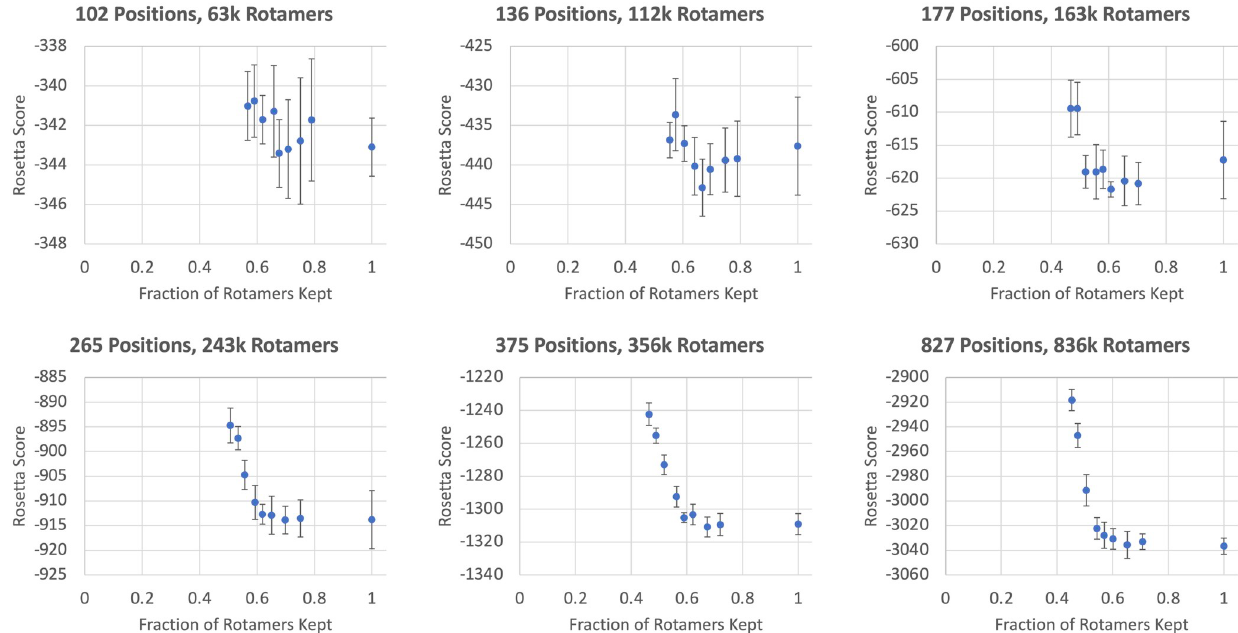
Fig 4. FixbbGCN benchmark results. Results of running Rosetta’s rotamer substitution protocol on six different protein backbones. FixbbGCN was used with various cutoffs to decrease the total rotamer count of each sample. The mean Rosetta scores (measured in REU) and standard deviations are displayed for each cutoff. The y-axes are truncated for the sake of readability. Protein data bank codes from left to right are (top row) 1SFX, 1ECO, 1D4O and (bottom row) 1W2C, 1O4S, 1PJ5.